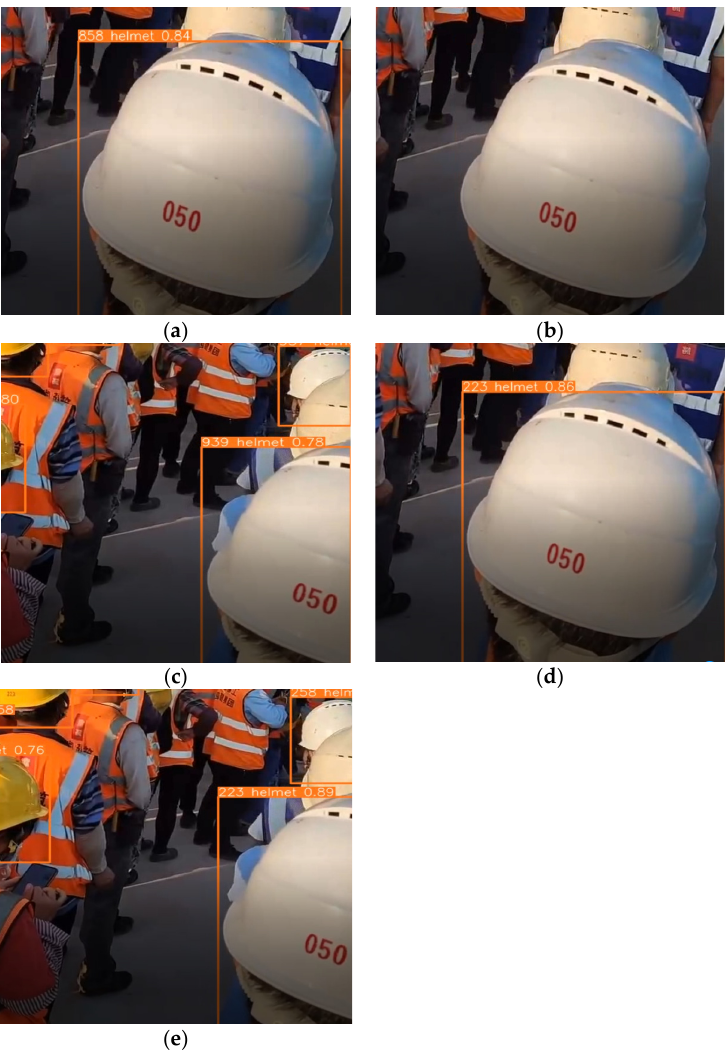
Figure 10. ID Status of same person in different frames in the video. ( a ) Frame 612; ( b ) Frame 689; ( c ) Frame 710; ( d ) Frame 670; ( e ) Frame 710.